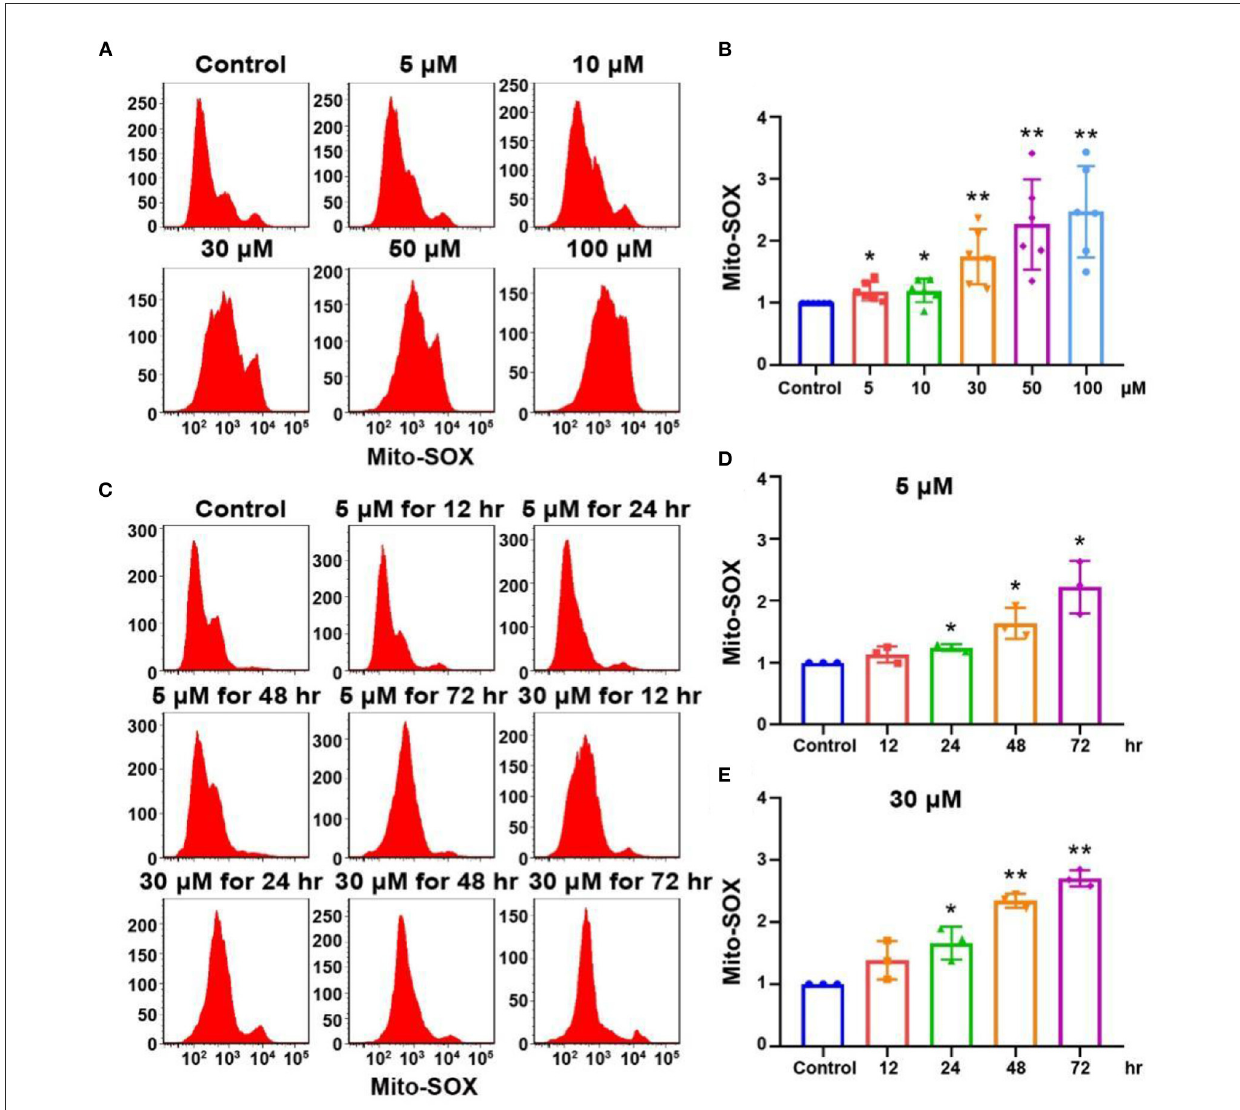
FIGURE3 Mito-SOX flow cytometry of OC-1 cells treated with different cisplatin concentrations and times. (A) ROS levels in cells treated with different cisplatin concentrations for 24h. (B) Quantification of the data in A. (C) ROS levels in cells treated with 5 or 30 µ M cisplatin for different times. (D) Quantification of the data in (C) . (E) Quantification of the data in (C) . * p < 0.05, ** p <